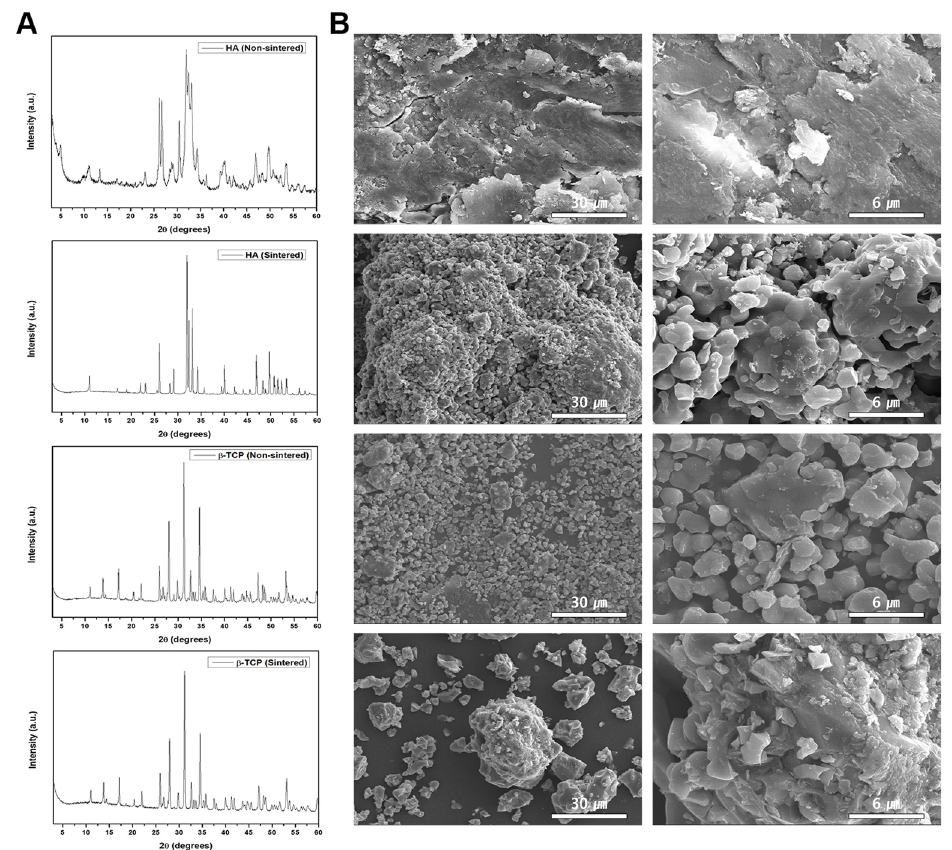
Figure 1. ( A ) X-ray diffraction (XRD) patterns and ( B ) field-emission scanning electron microscopy (SEM) images of sintered and non-sintered hydroxy apatite (HA) and beta-tricalcium phosphate ( β -TCP). Scale bar = left(30 μ m), right(6 μ m)